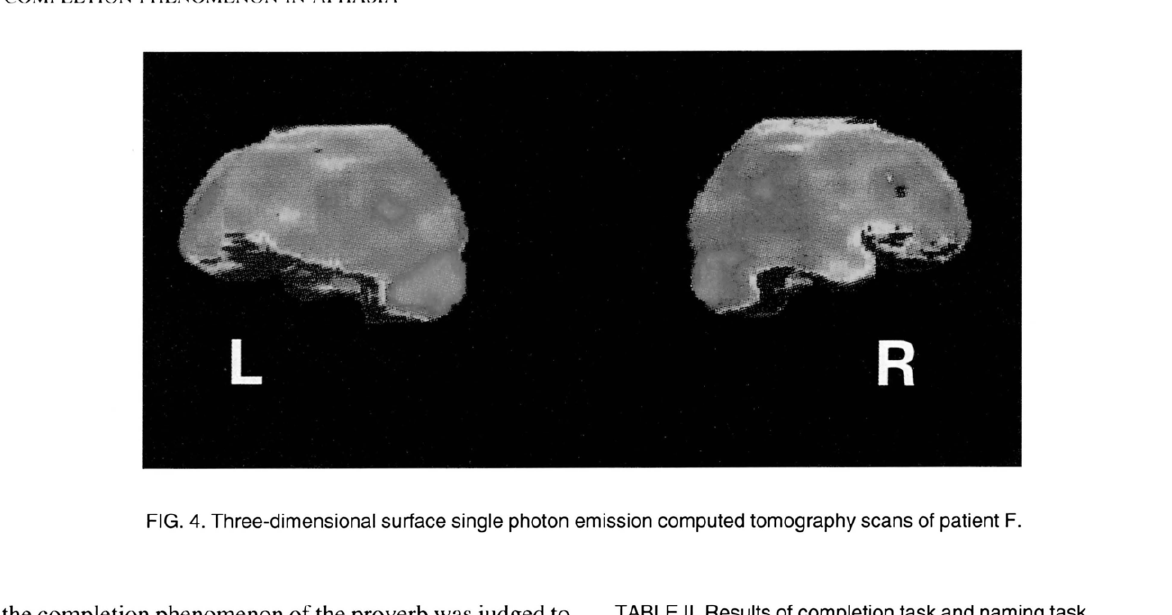
TABLE II. Results of completion task and naming